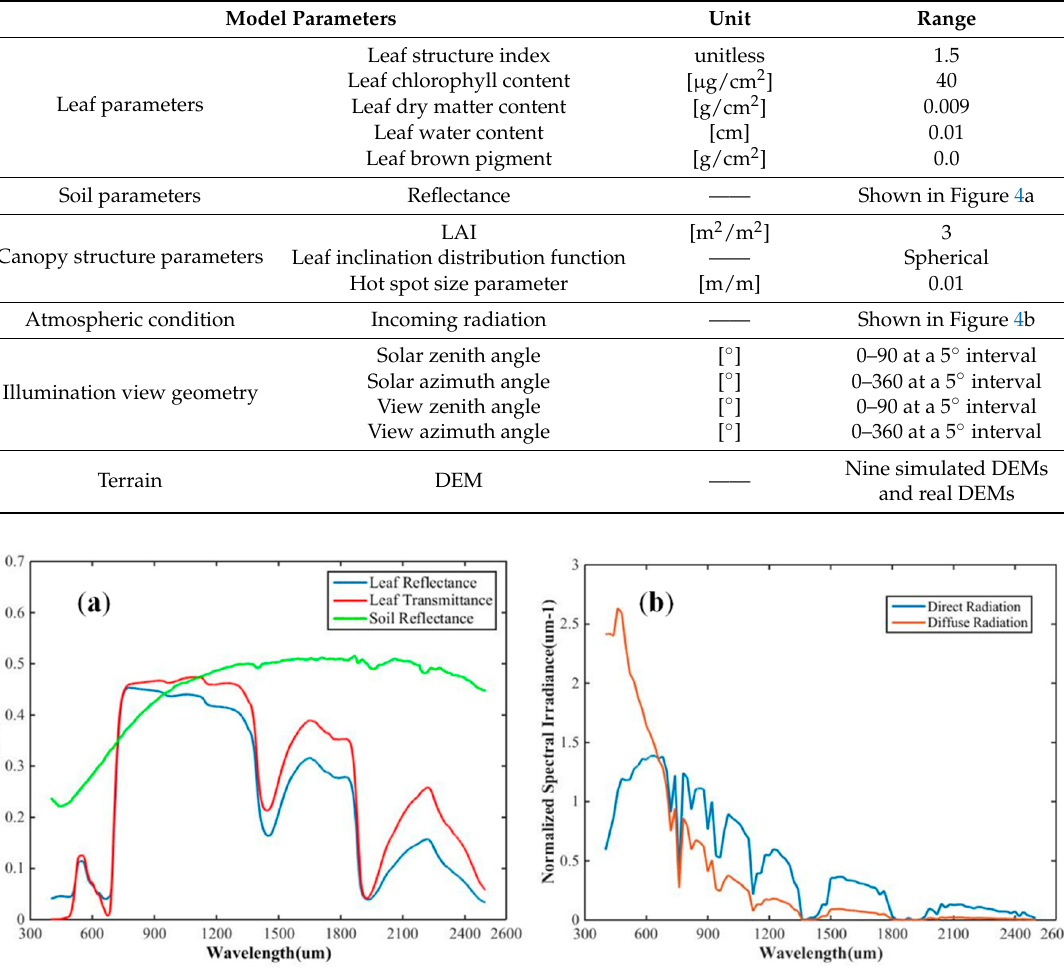
Table 2. Specification of input parameters in the PROSAIL model.